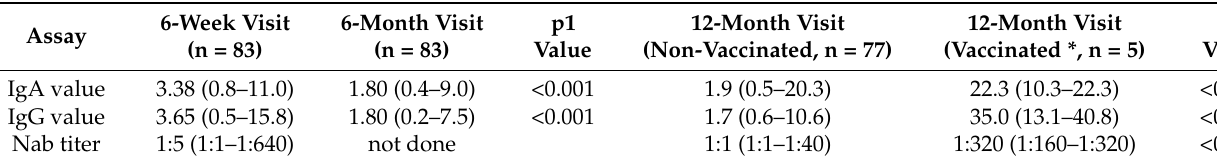
Figure 4. Course of IgA/IgG antibody level ( A , B ) and specific T-cells ( C , D ) over time. Black lines in boxplots represent median values. * p < 0.001 significant value. At 12-months measurement points, only non-vaccinated participants were considered.